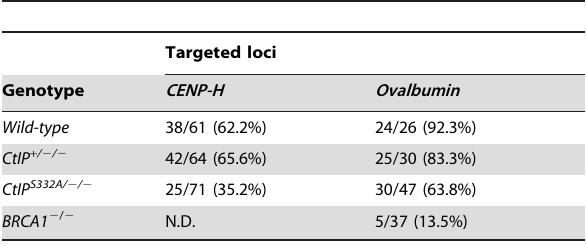
Table 2. Targeted integration frequencies of CtIP S332A/ 2 / 2